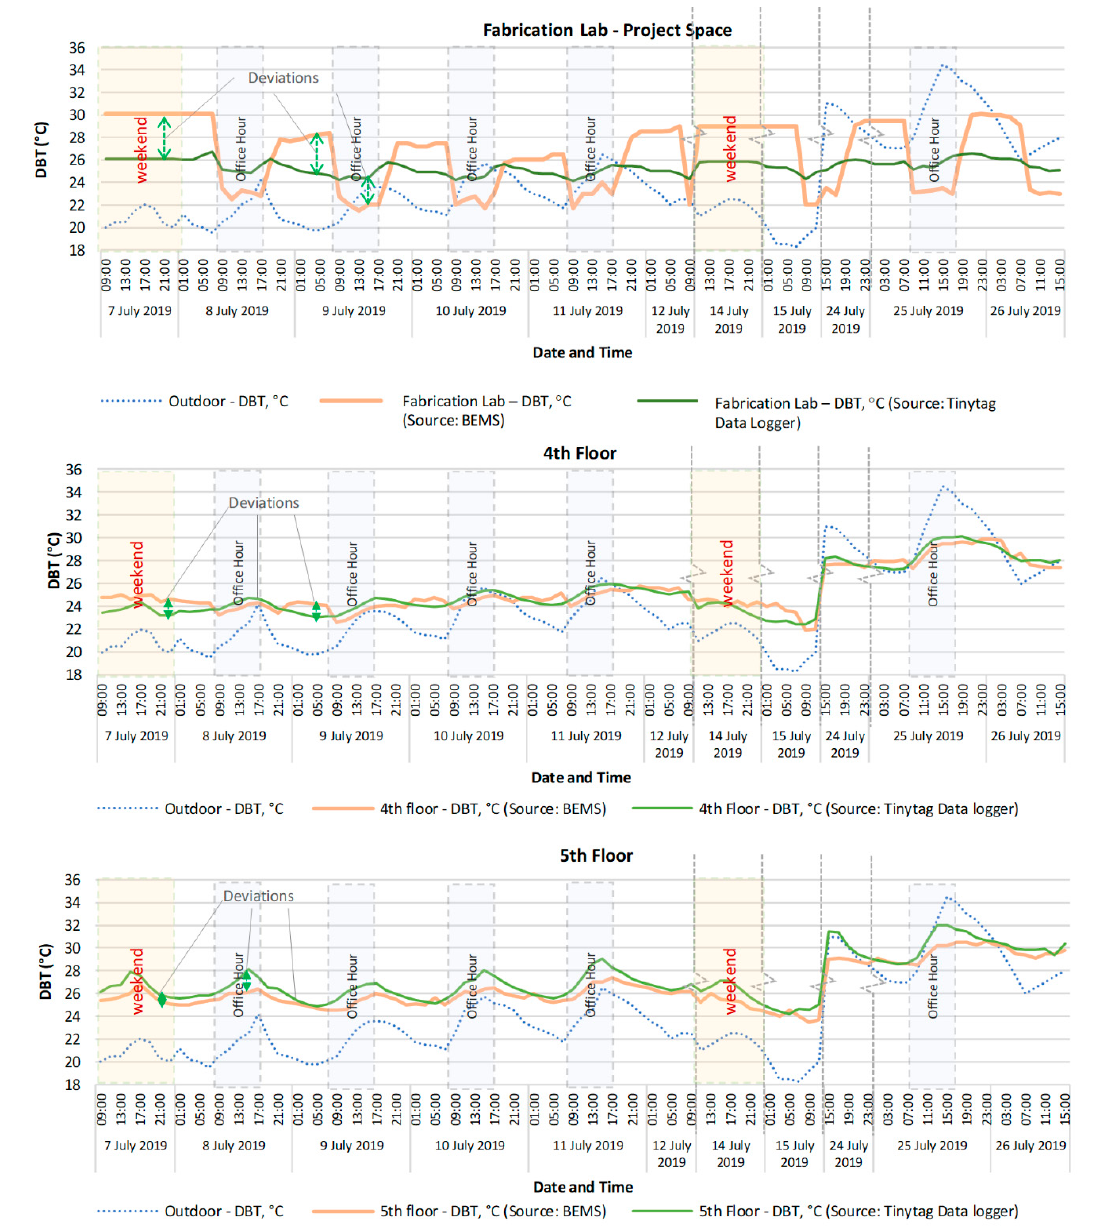
Figure 9. Recorded DBTs using BEMS and Tinytag sensors (source: BEMS sensors and Tinytag data loggers, outdoor DBT collected from BEMS outdoor space sensor).